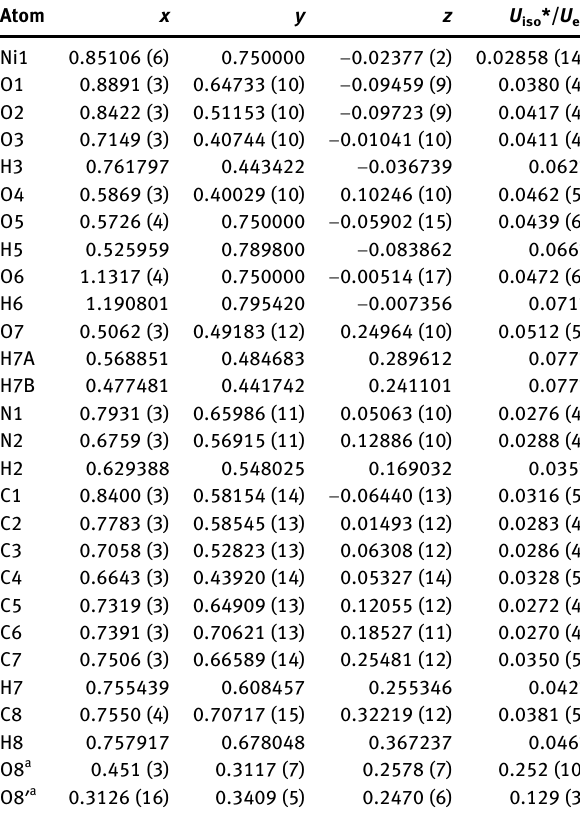
Table  : Fractional atomic coordinates and isotropic or equivalent isotropic displacement parameters (Å 